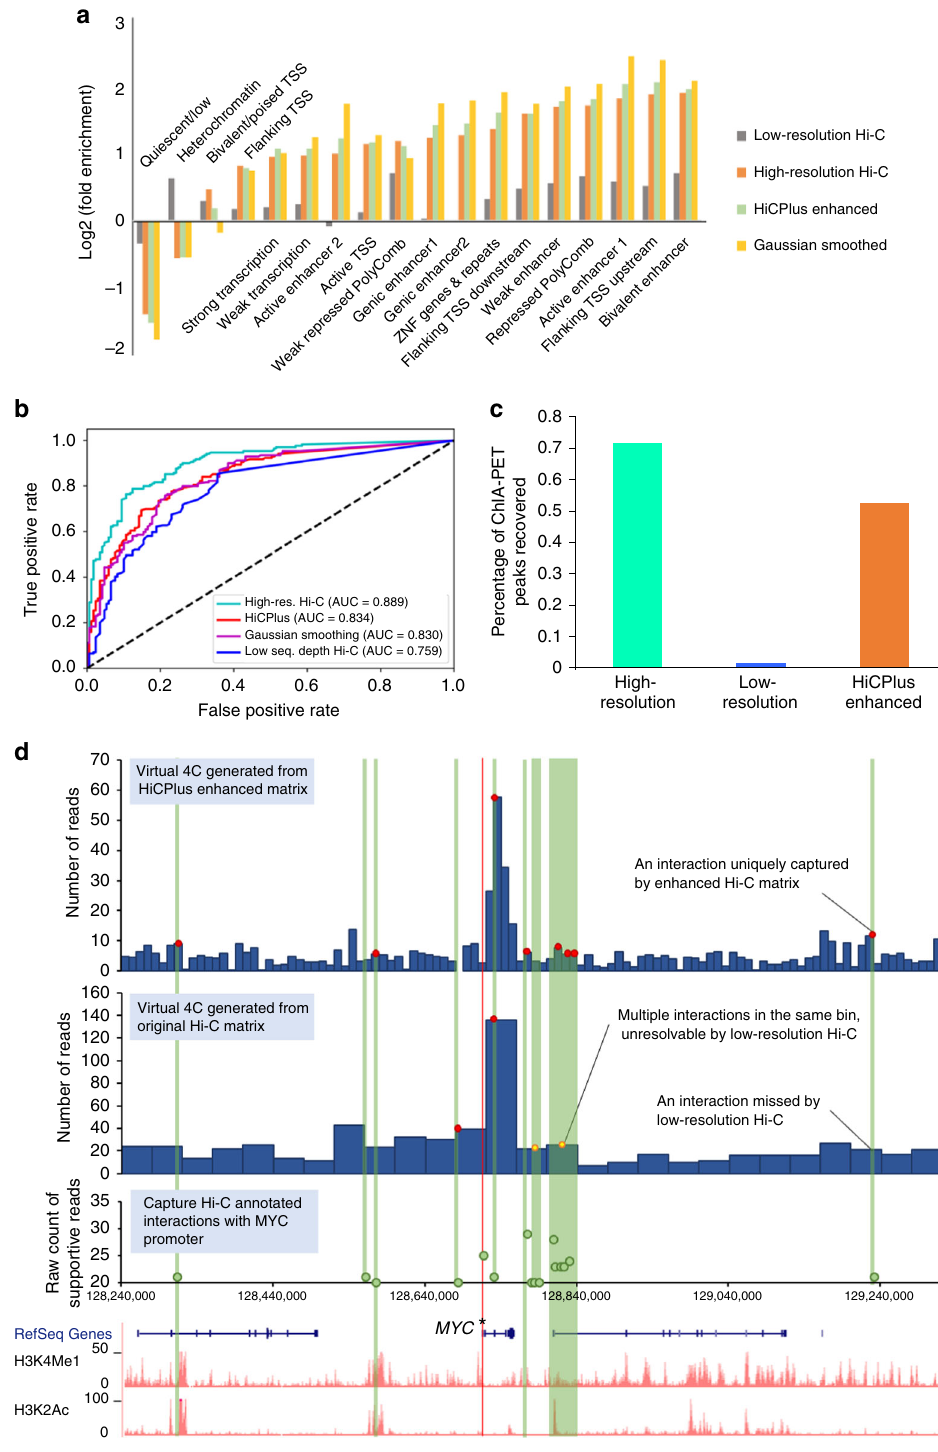
curve) to evaluate the performance of our model. As shown in Fig. 5b, CTCF interacting pairs and non-interacting pairs are separated in the predicted results from HiCPlus-enhanced matrix (average AUC = 0.85). We also observed that the AUC score for the HiCPlus-enhanced matrix is signi fi cantly higher than the AUC from the down-sampled matrix ( p -value < 0.05). Finally, we compared the overlap between signi fi cant interactions identi fi